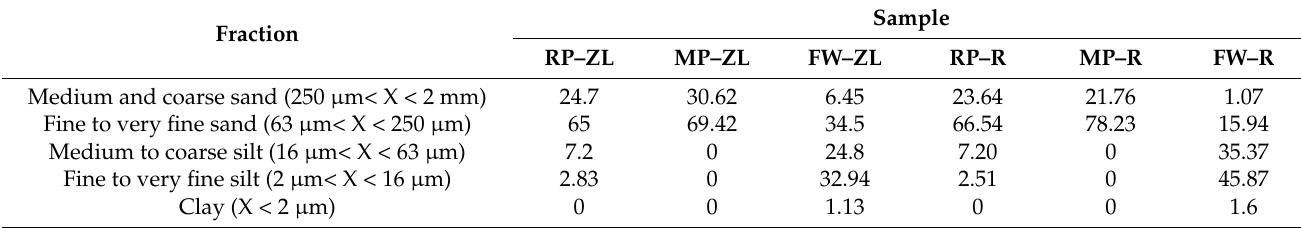
Table 1. Particle-size distribution (% of dry sample). RP: raw phosphate; MP: marketable phosphate, and FW: fine waste from M’Dhilla-Zone L (ZL) and Redeyef (R) laundries. Sample Fraction RP–ZL MP–ZL FW–ZL RP–R MP–R FW–R Medium and coarse sand (250 µ m< X < 2 mm) 24.7 Fine to very fine sand (63 µ m< X < 250 µ m) Medium to coarse silt (16 µ m< X < 63 µ m) Fine to very fine silt (2 µ m< X < 16 µ m) Clay (X < 2 µ m)